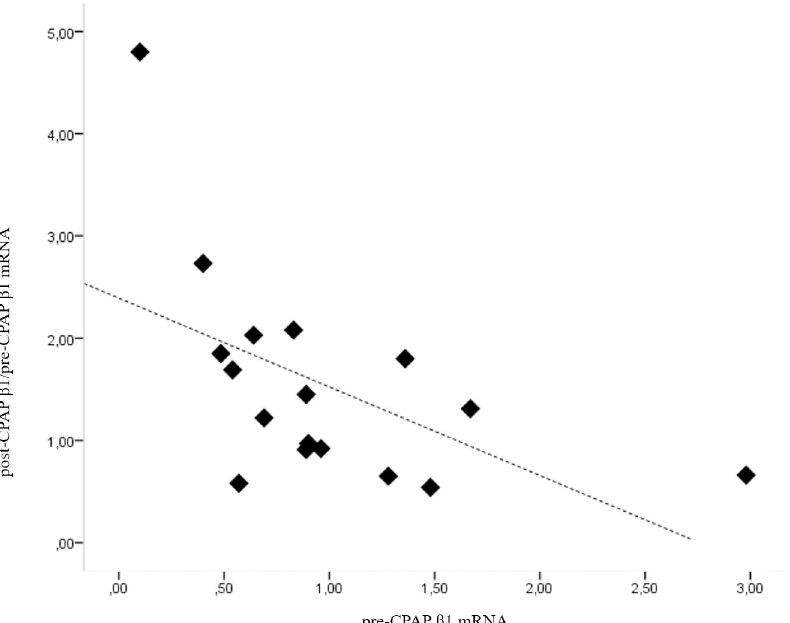
Fig 2. There is a correlation between β 1-subunit mRNA expression at baseline and its change after 3 months of CPAP treatment. Pre-CPAP β 1 mRNA: β 1-subunit mRNA expression at baseline, post-CPAP β 1 mRNA / pre-CPAP β 1 mRNA: ratio of β 1-subunit mRNA expression after 3 months of CPAP treatment to that at baseline. p =